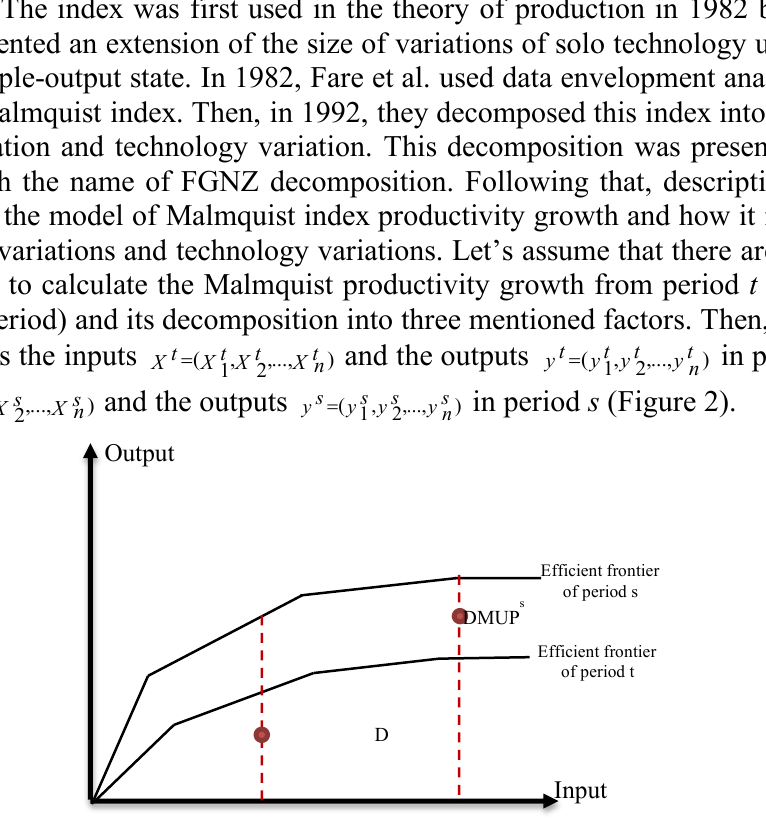
Figure 2. Efficiency frontier of first and second periods in Malmquist